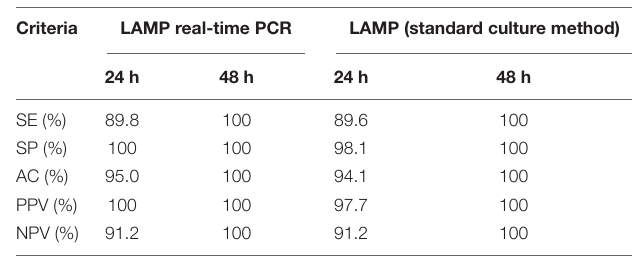
TABLE 4 | Diagnostic criteria of the rplD LAMP assay compared with real-time PCR and the standard culture method after examination of naturally contaminated meat products after 24- and 48-h